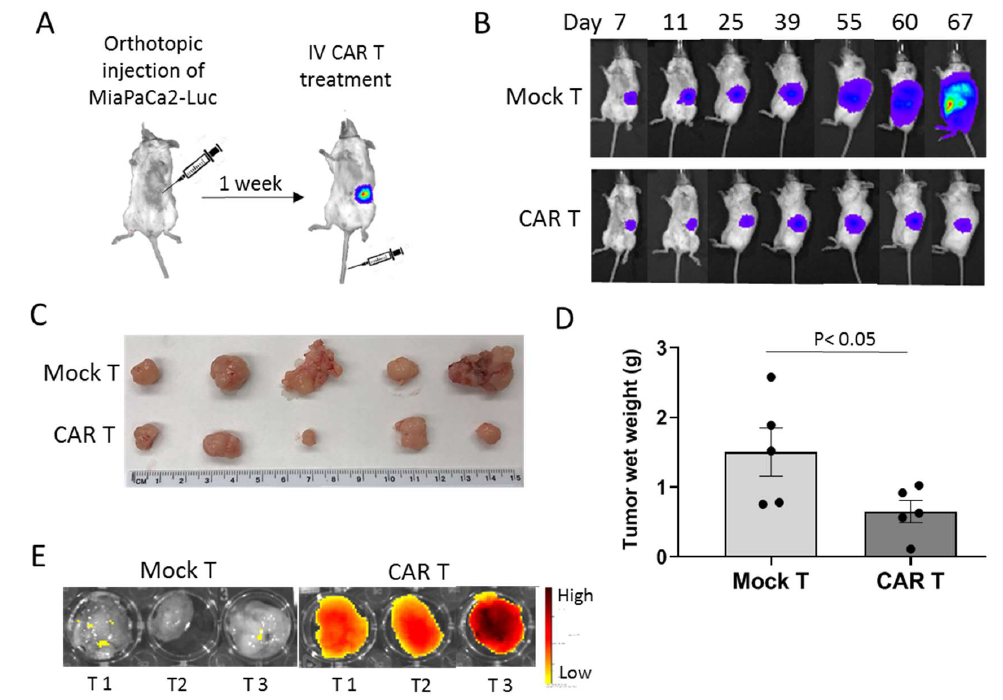
Figure 4. tMUC1-CAR T cells control pancreatic tumor growth in vivo. ( A ) Establishing the mouse model of human PDA using orthotopic injection of MiaPaCa2-Luc cancer cells into the pancreas. 7 days post-surgery, tumor presence was confirmed using in vivo imaging system (IVIS). On day 8, mice were randomized into two groups and injected IV with 10 × 10 6 mock or CAR T cells. Images were taken 8 min after luciferin injection using IVIS system. ( B ) Serial IVIS images of MiaPaCa2-Luc implanted mice treated with mock or CAR T started on day 7 post tumor inoculation. One mouse per group is shown as representative of 6 mice. ( C ) Images of the tumors harvested from mice treated with mock T or CAR T cells on day 68 post tumor inoculation. ( D ) Tumor wet weights of the mice treated with mock T or CAR T cells on day 68 after tumor inoculation. Significance of data was evaluated using Non-parametric Mann-Whitney U test. p = 0.05 ( n = 5). ( E ) Visual representation of CAR T cells tra ffi cking in the pancreatic tumors. To evaluate T cells tra ffi cking into the fibrotic pancreatic tumor, six tumor-bearing mice (day 52 post-surgery) were injected IV with either 4 × 10 6 vivotrack-680 labeled-CAR T or mock T cells. After 24 h, mice were scarified and tumors were harvested and imaged using fluorescent channel on IVIS machine with excitation = 676 and emission = 696 nm. The fluorescent signal acquired from tumors of mice treated with CAR T cells was significantly higher than the ones treated with mock T cells, which indicates more CAR T cells are directed to the tumor site than mock T cells. T1-3, tumor